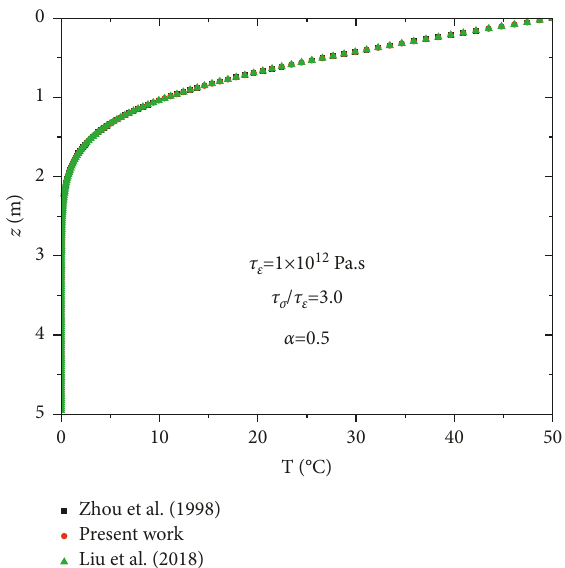
Figure 4: Comparison of temperature increment among solutions of Zhou et al. [25], Liu et al. [14], and present work.